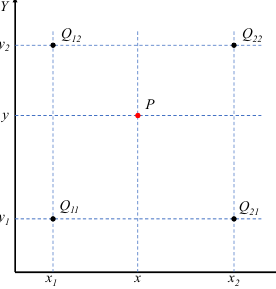
Figure 5. Schematic diagram of the bilinear interpolation